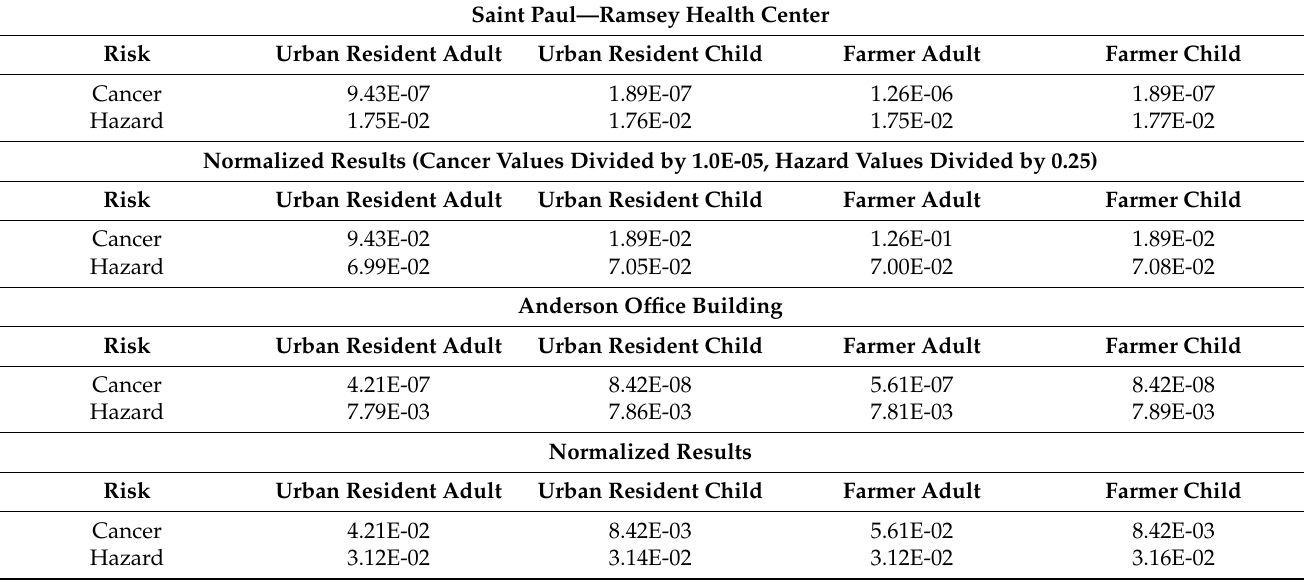
Table 11. Total Individual Formaldehyde Cancer Risks and Noncancer Hazards. Saint Paul—Ramsey Health